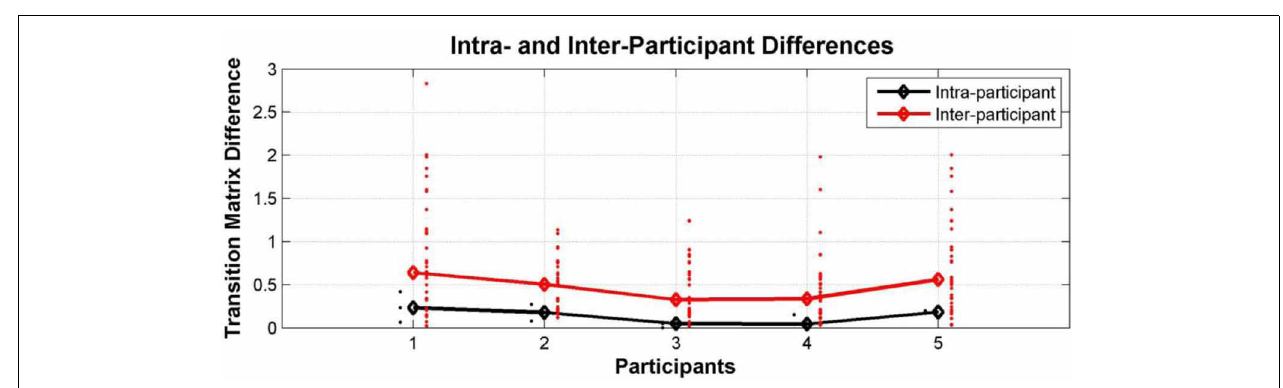
FIGURE 12 | Comparison between intra- and inter-individual perceptual switching behavior in Experiment 3; differences between transition matrices from the same participant at different sessions (black dots;